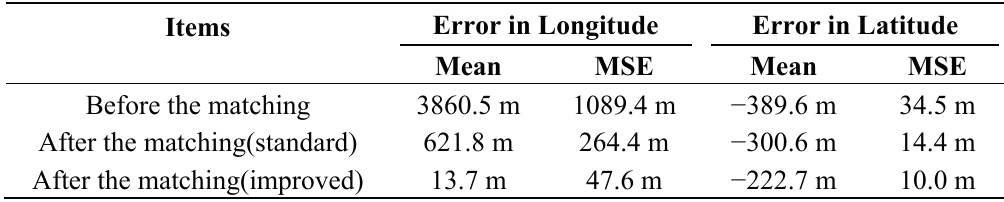
Table 8. Positioning error of gravity matching navigation in the ocean experiment. Items Error in Longitude Error in Latitude Mean MSE Mean MSE Before the matching 3860.5 m 1089.4 m − 389.6 m 34.5 m After the matching(standard) 621.8 m 264.4 m − 300.6 m 14.4 m After the matching(improved) 13.7 m 47.6 m 10.0